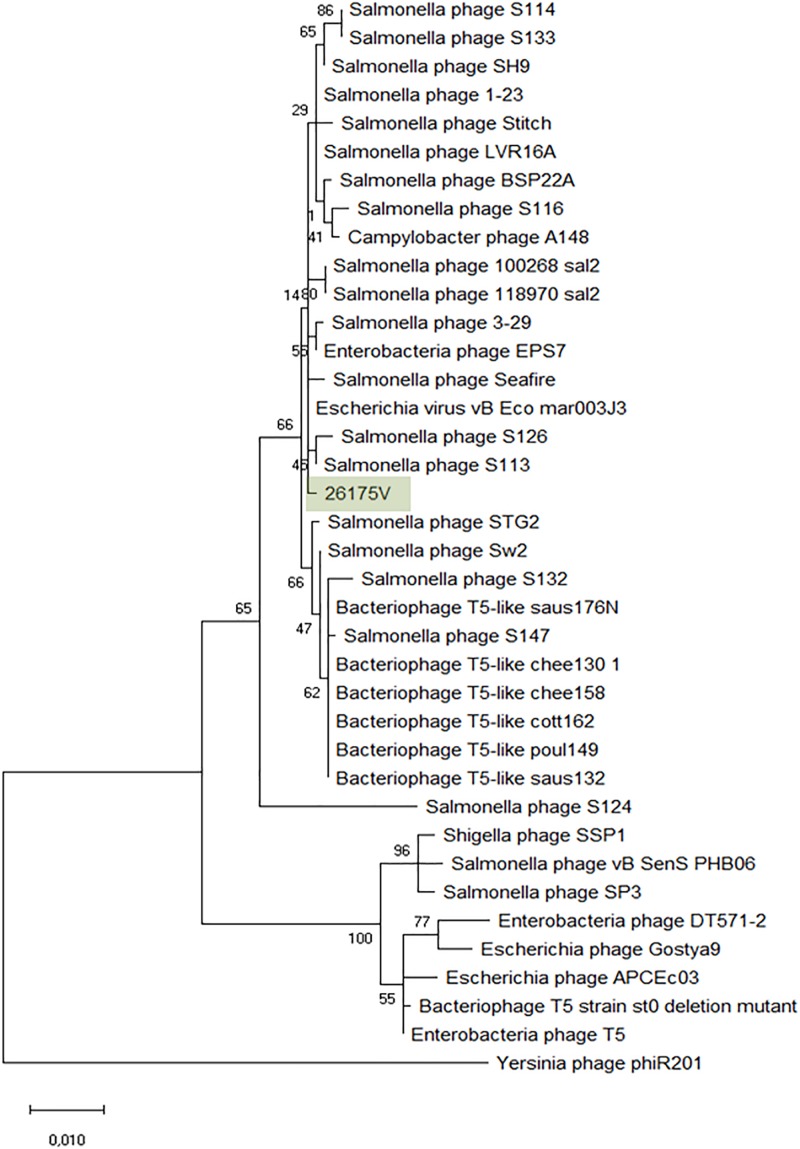
Phylogenetic tree of Tequintavirus phage based on the Clustal Omega alignment of the DNA polymerase I protein sequence of the representative phage vB_EcoS-26175V (MK907271). The percentage of trees in which the associated taxa clustered together is shown next to the branches. The list of genomes included and GenBank accession numbers are described in Supplementary Data S5.